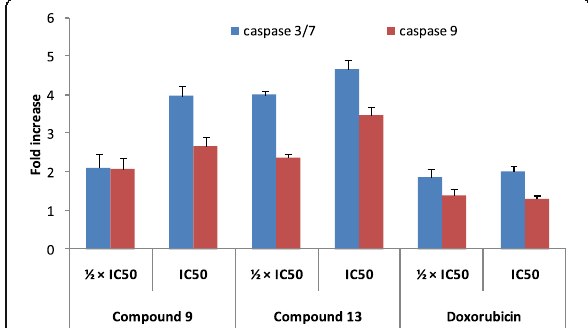
Fig. 3 Activity of caspases 3/7 and 9 in MCF-7 cells treated with thonningiol (9), seputhecarpan D (13) and doxorubicin for 6 h. IC 50 : 0.36 μ M (thonningiol), 9.78 μ M (seputhecarpan D)